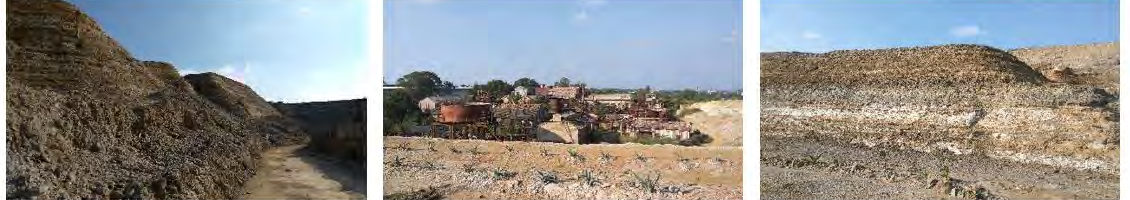
Figure 13. Milltailing/ dump and abandoned processing unit.